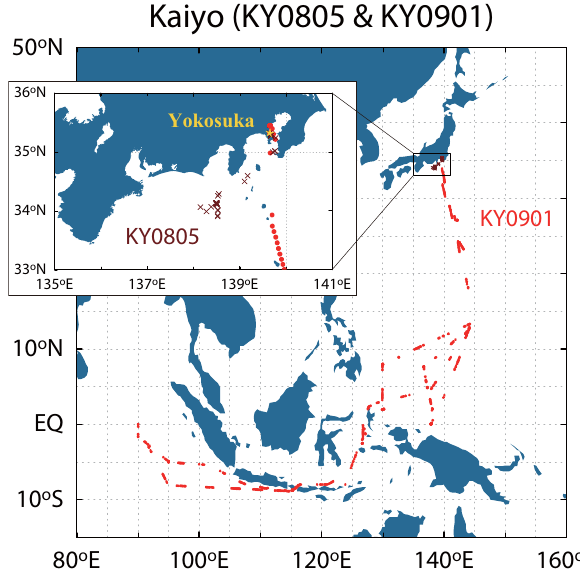
Fig. 1. Ship routes during the two ocean cruises by the Japanese R/V Kaiyo (KY0805 and